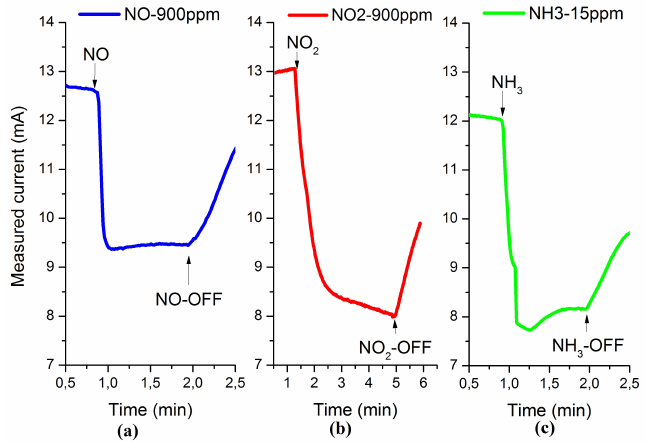
Figure 8. Response of the HEMT sensor to ( a ) 900 ppm NO; ( b ) 900 ppm NO 2 ; and ( c ) 15 ppm NH 3 at 600 °C.